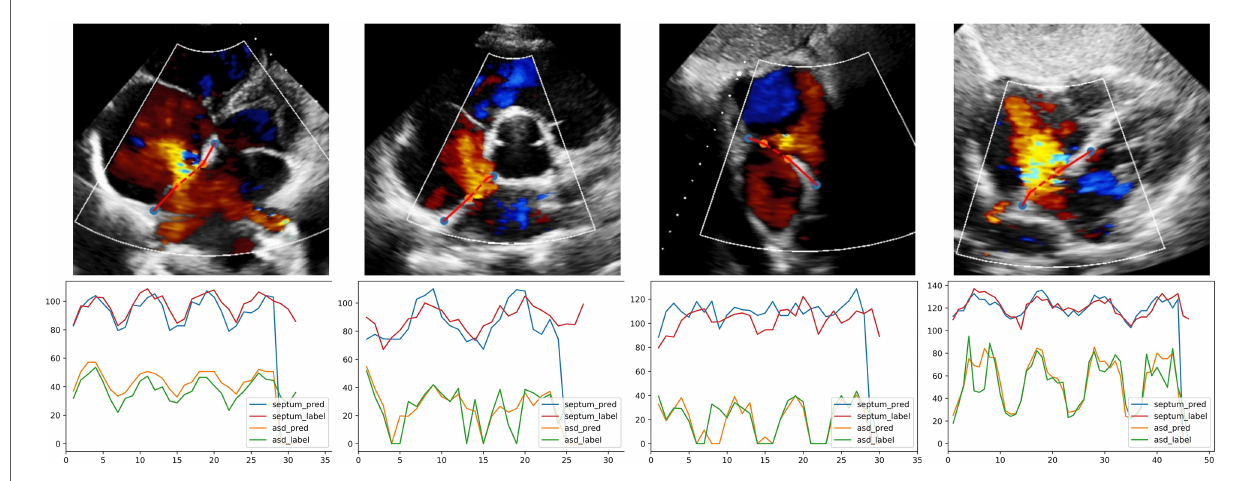
FIGURE 5 The output of quanti fi cation model in different views. The fi rst row, one example test image of patients with ASD is shown respectively in A4C, PSAX, SC2A and SC4C view; orange and blue dots are the endpoints of defect and septum predicted by DL model. The second row, corresponding curves showing the variation of defect and septum in the video. Abbreviations as in Figure 1